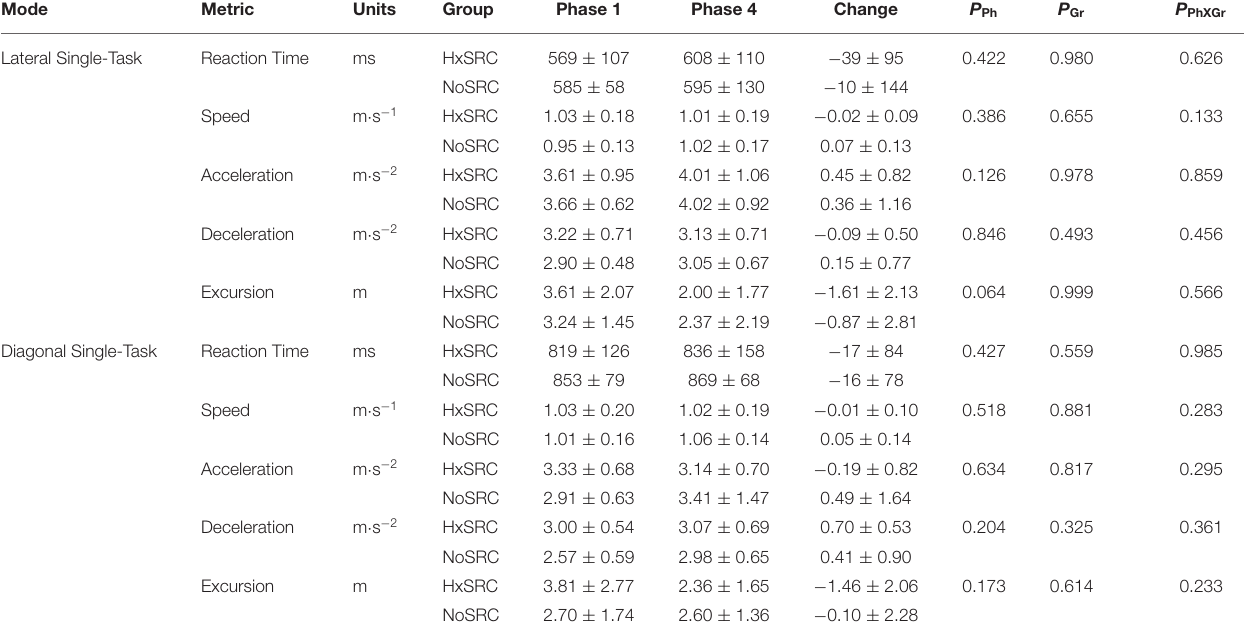
TABLE 4 | Group mean ± standard deviation for Single-Task performance.